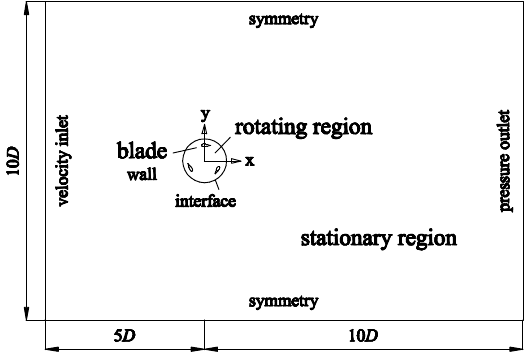
Figure 2. Schematic of computational region.